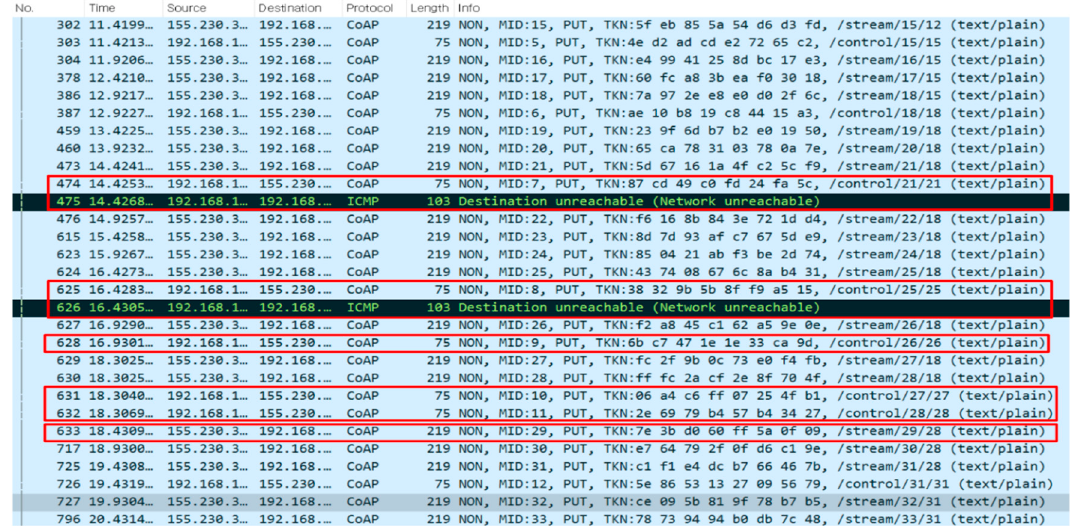
Figure 14. Packets of flow control for CoAP-SC.